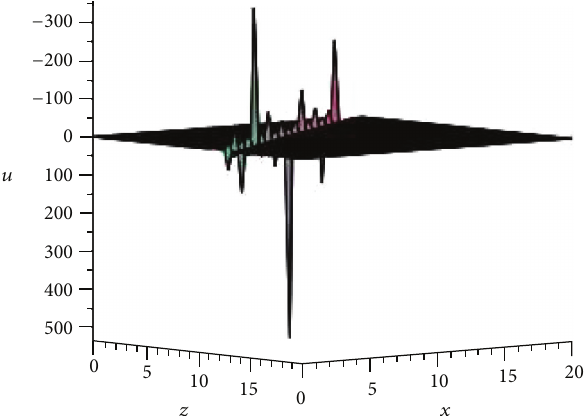
Figure 6: The shape of the 1-negaton of second-order to (1) with = −1 , 𝑦 = 0 , 𝑡 = 0 , 𝛾 𝜆 1